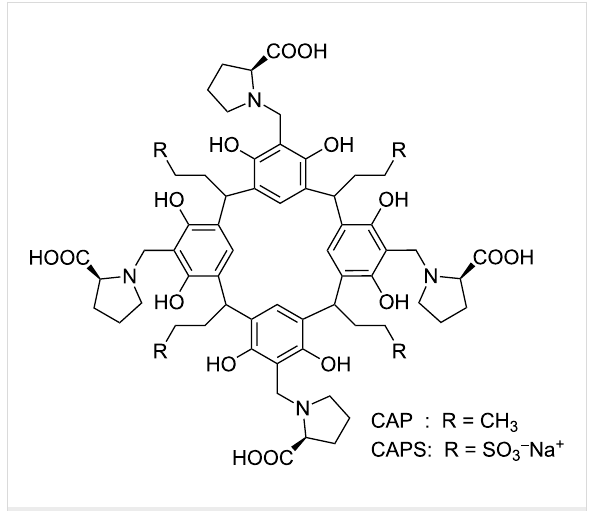
Figure 1: Structure of the L-proline-calix[4]resorcinarene derivatives CAP and